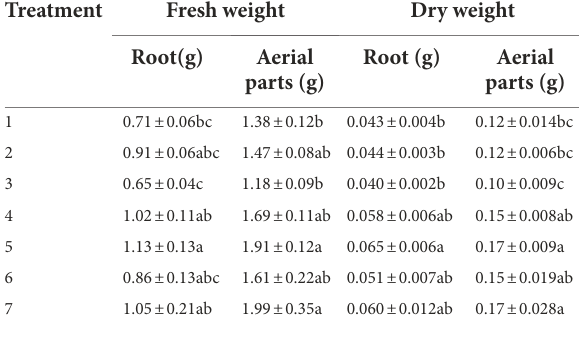
TABLE 6 Effects of SDTB038 on fresh and dry weight of tomato seedlings.